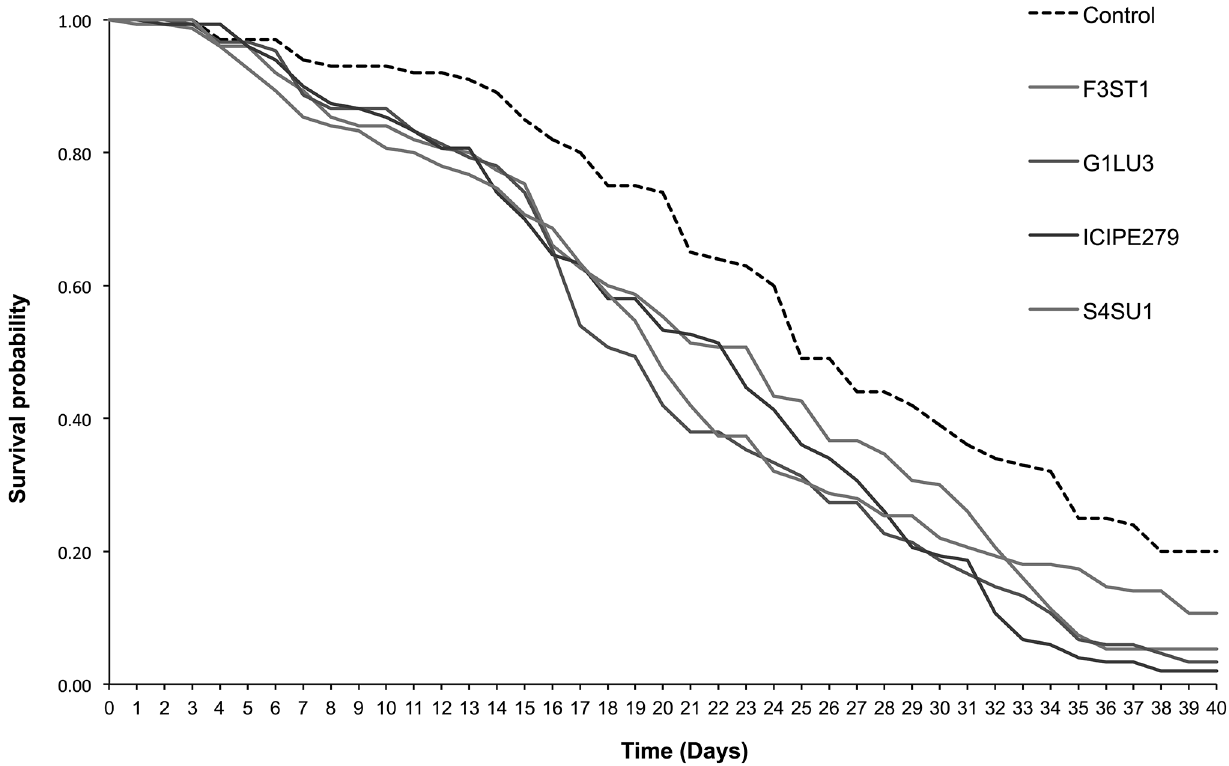
Figure 2. Survival curves for Phaedrotomascabriventris adults parasitizing 2 nd and 3 rd instar Liriomyzahuidobrensis larvae following exposure to Viciafaba plants endophytically-colonized by different fungal isolates of Beauveriabassiana (S4SU1, G1LU3 and ICIPE 279) and Hypocrealixii F3ST1 after 40 days post-exposure.